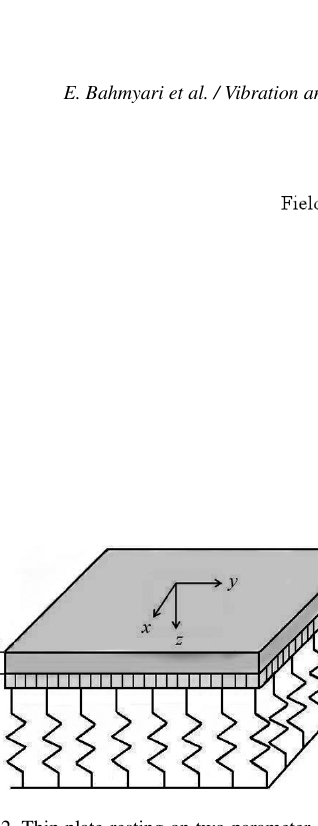
Fig. 2. Thin plate resting on two parameter elastic foundation and co- ordinate system.